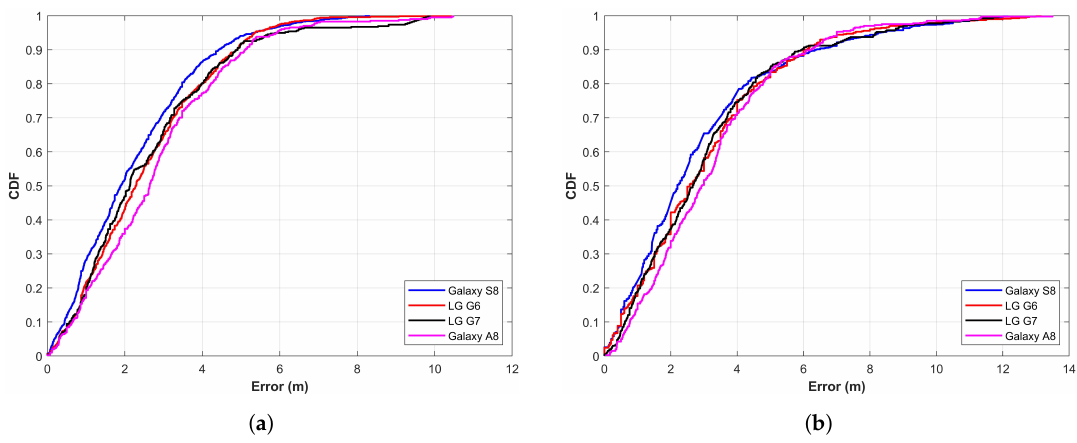
Figure 11. The CDF graph when using features from magnetic x , y , z , and F , ( a ) Scenario 1 and ( b ) Scenario 2.